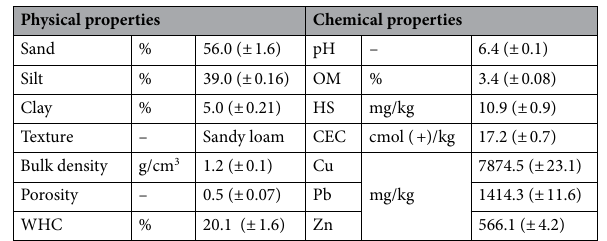
Table 1. Physical and chemical properties of spiked soil (n = 3, ± standard deviation). OM organic matter, HS humic substances, CEC cation exchange capacity, WHC water holding